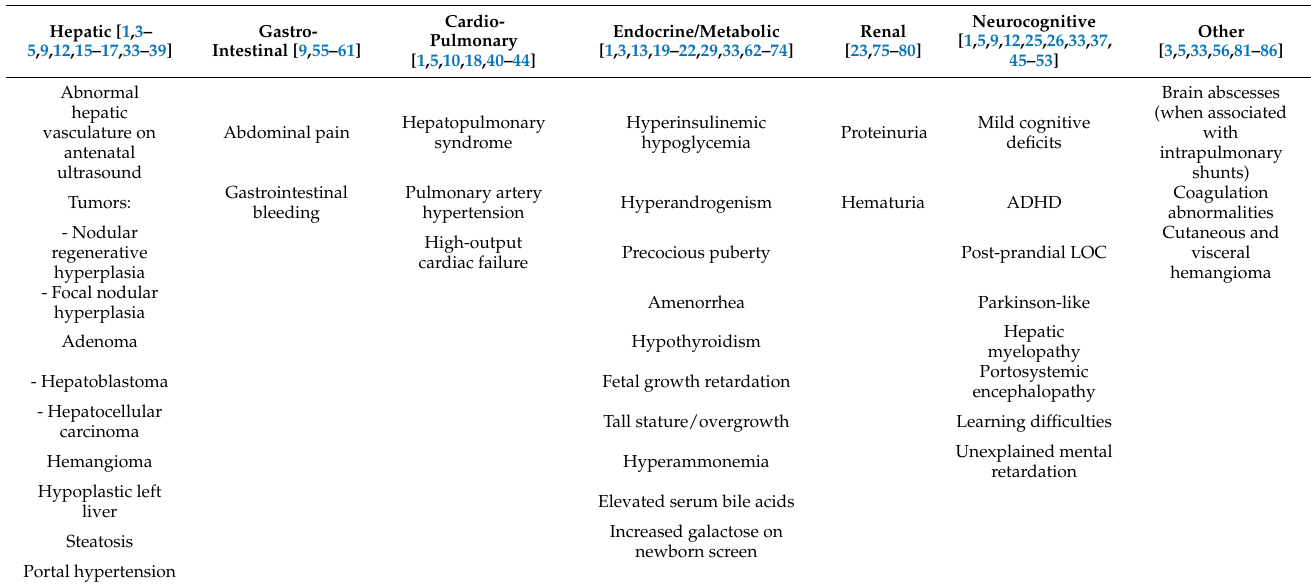
Table 3. Clinical and biological symptoms and signs encountered in patients with congenital por- tosystemic shunts. Signs and symptoms not in order of frequency of presentation. ADHD = attention deficit hyperactivity disorder; LOC = loss of